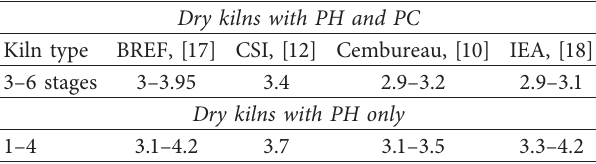
Table 1: Thermal energy consumption for dry kilns